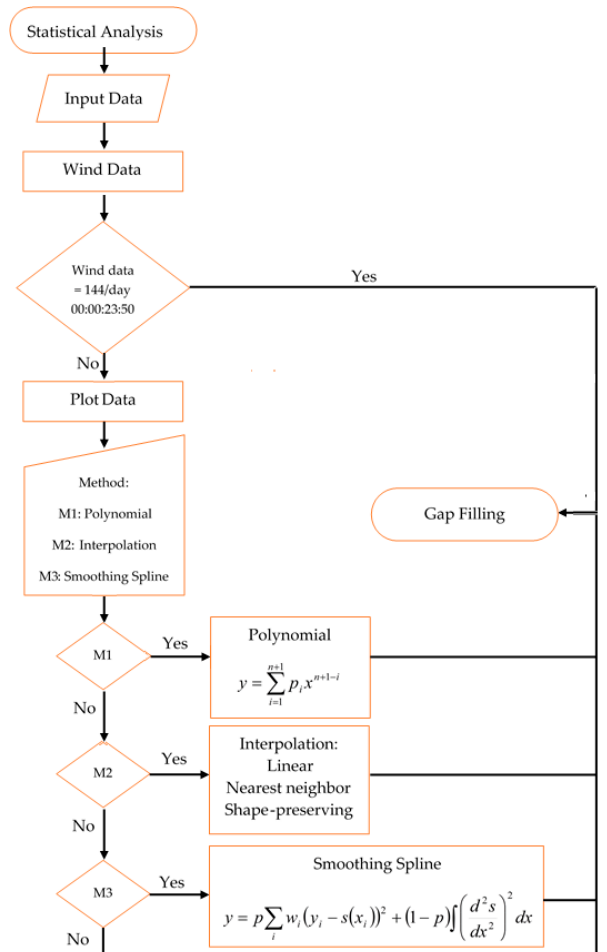
Figure 1. Gap filling algorithm.